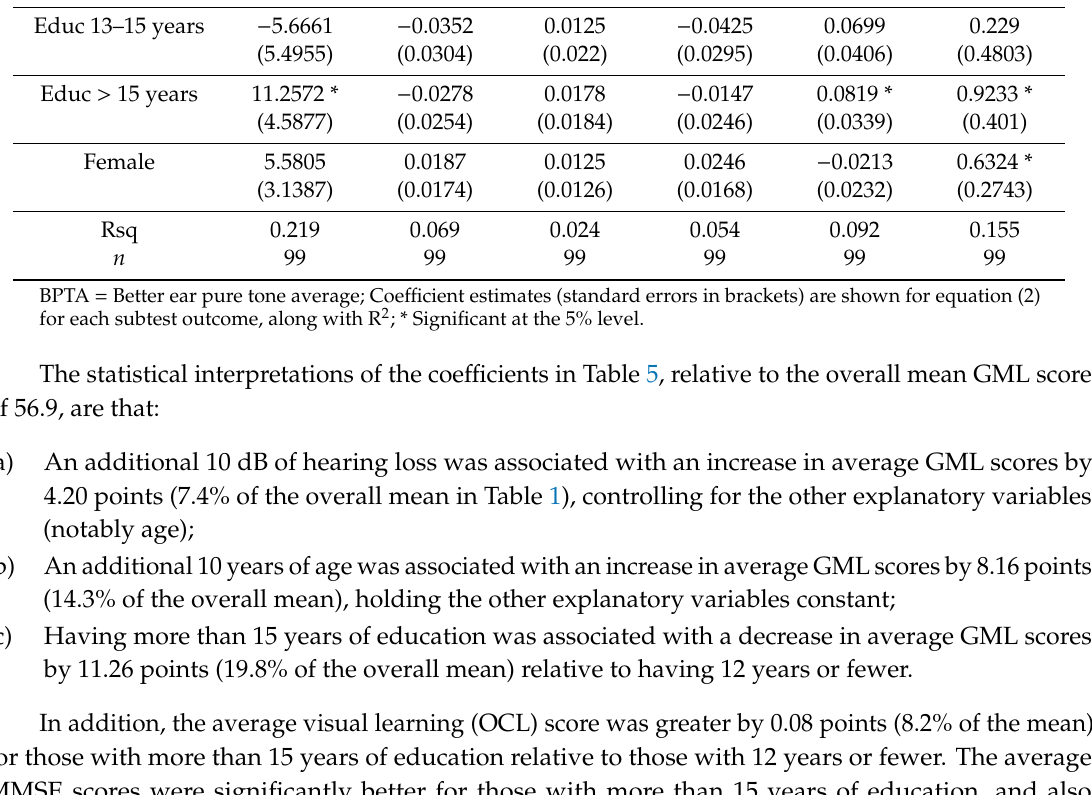
Table 5. Regression results at baseline for Equation (2) for each of the CogState battery subtests and the MMSE ( n = 99). GML DET IDN ONB OCL MMSE Intercept − 9.8798 2.3531 * 2.6761 * 2.8260 * 1.0761 * 29.5289 * (26.1775) (0.1449) (0.1049) (0.1405) (0.1933) (2.288) BPTA 4.2037 * 0.0015 0.006 − 0.0007 − 0.0079 − 0.2455 (2.0044) (0.0111) (0.008) (0.0108) (0.0148) (0.1752) Age 8.1570 * 0.0343 0.0089 0.0189 − 0.0182 − 0.1417 (3.2699) (0.0181) (0.0131) (0.0175) (0.0241) (0.2858) Educ 13–15 years − 5.6661 − 0.0352 0.0125 − 0.0425 0.0699 0.229 (5.4955) (0.0304) (0.022) (0.0295) (0.0406) (0.4803) Educ > 15 years 11.2572 * − 0.0278 0.0178 − 0.0147 0.0819 * 0.9233 * (4.5877) (0.0254) (0.0184) (0.0246) (0.0339) (0.401) Female 5.5805 0.0187 0.0125 0.0246 − 0.0213 0.6324 * (3.1387) (0.0174) (0.0126) (0.0168) (0.0232) (0.2743) Rsq 0.219 0.069 0.024 0.054 0.092 0.155 n 99 99 99 99 99